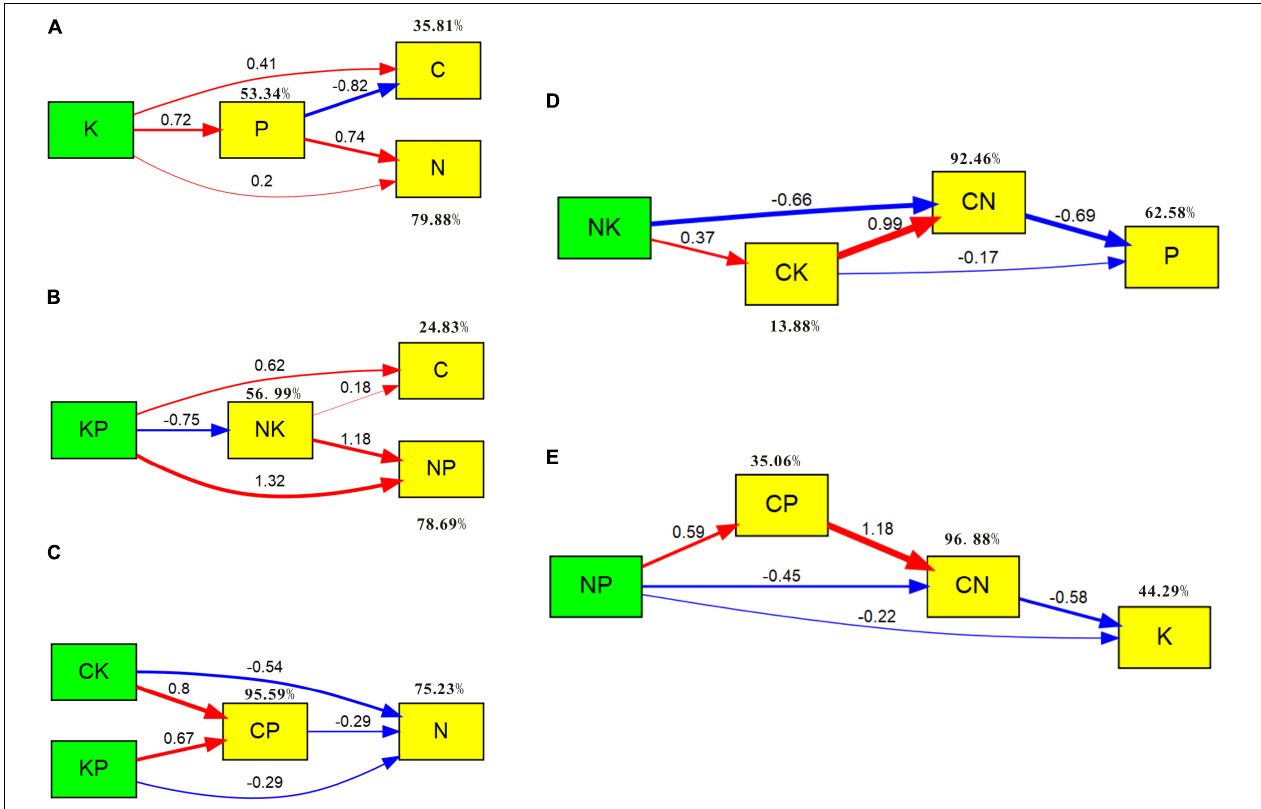
FIGURE 7 | SEM of plant C, N, P, K concentrations and the corresponding ratios. Red and blue solid arrows indicate the significant positive and negative pathways, respectively. Numbers in the arrows indicate the path coefficients. Percentage values close to the variables refer to the proportion of explained variance (R 2 ) by the model. (A) The SEM of plant C, N, P, and K concentrations ( χ 2 = 0.428, p = 0.513, GFI = 0.995). (B) The SEM of plant C concentration, N:P ratio (NP), K:P ratio (KP), and N:K ratio (NK; χ 2 = 0.000, p = 0.987, GFI = 1.000). (C) The SEM of plant N concentration, C:K ratio (CK), C:P ratio (CP), and K:P ratio ( χ 2 = 0.774, p = 0.379, GFI = 0.991). (D) The SEM of plant P concentration, C:N ratio (CN), C:K ratio, and N:K ratio ( χ 2 = 0.009, p = 0.925, GFI = 1.000). (E) The SEM of plant K concentration, C:N ratio, C:P ratio, and N:P ratio ( χ 2 = 1.511, p = 0.219, GFI =